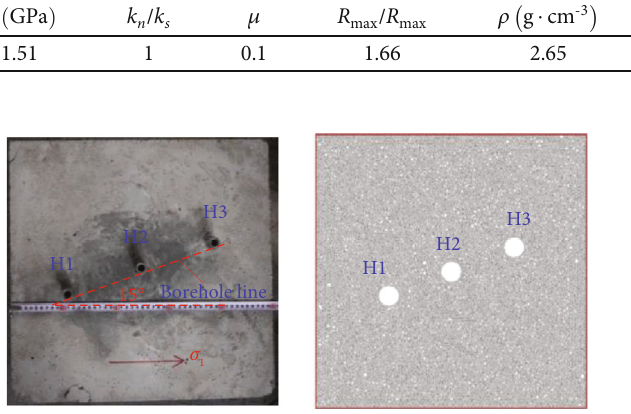
Figure 8: Test block for laboratory test and numerical